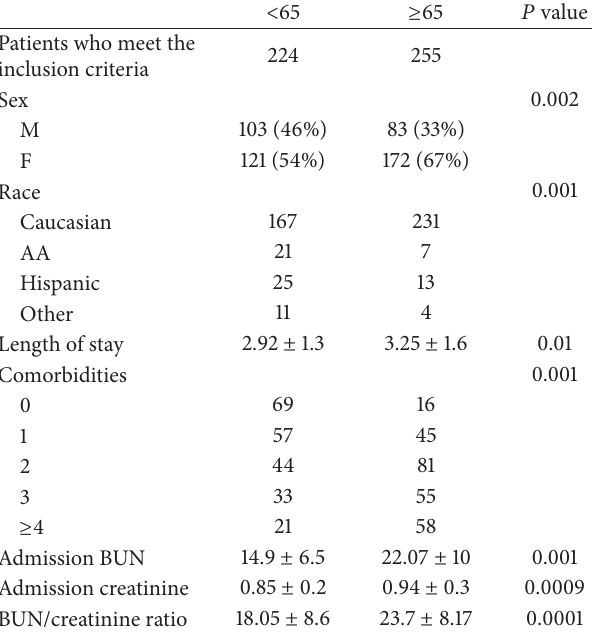
Table 1: Baseline characteristics of the